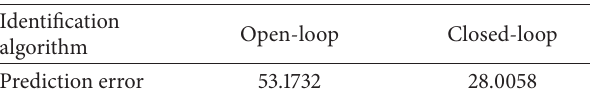
Table 3: The prediction errors of open-loop and closed-loop identified evaporator model.